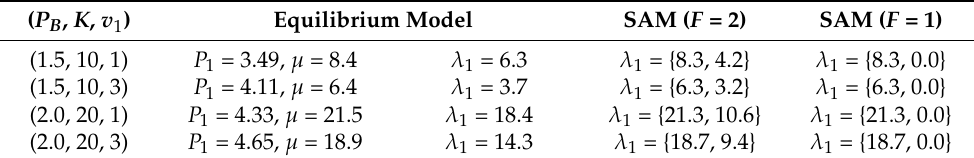
Table 2. Small capacity networks with infrequent arrival rate broadcast (Case